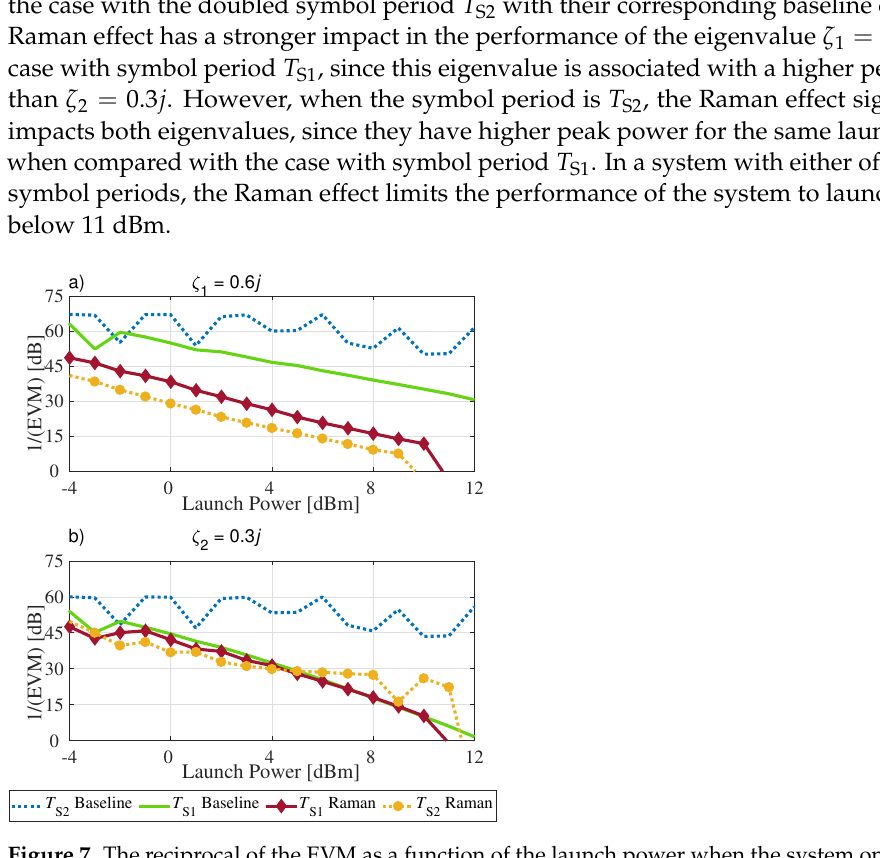
Figure 7. The reciprocal of the EVM as a function of the launch power when the system only includes the Raman effect. ( a ) Results of a signal that is decoded from the first eigenvalue ζ 1 = 0.6 j . ( b ) Results of a signal that is decoded from the second eigenvalue ζ 2 = 0.3 j . We show results for the system with symbol period equal to T S1 and for the system with symbol period equal to T S2 = 2 T S1 . The system with the smaller symbol period T S1 outperforms the system with the larger symbol period T S 2 as shown in Figure 7a. This performance difference occurs because the simulation with symbol period T S2 has significantly higher peak power than that of the simulation with T S1 to correspond to the same launch power. The Raman effect causes a shift in the spectrum of the waveform towards longer wavelengths. The narrow portion of the waveform with higher instantaneous power, which is associated with the larger eigenvalue, moves more slowly due to changes in its group velocity due to the Raman effect